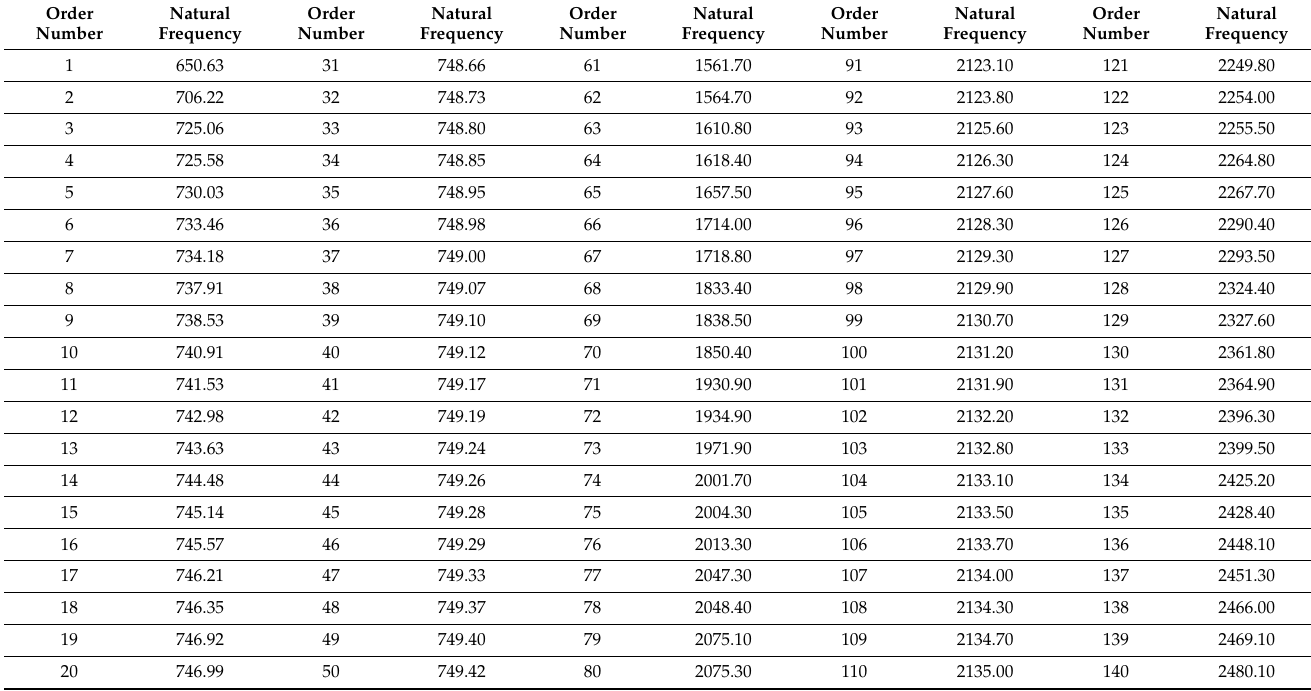
Figure 12. Finite element model of the second-stage bladed disk. Table 6. Natural frequencies of the first 150 orders of the second-stage blading disk